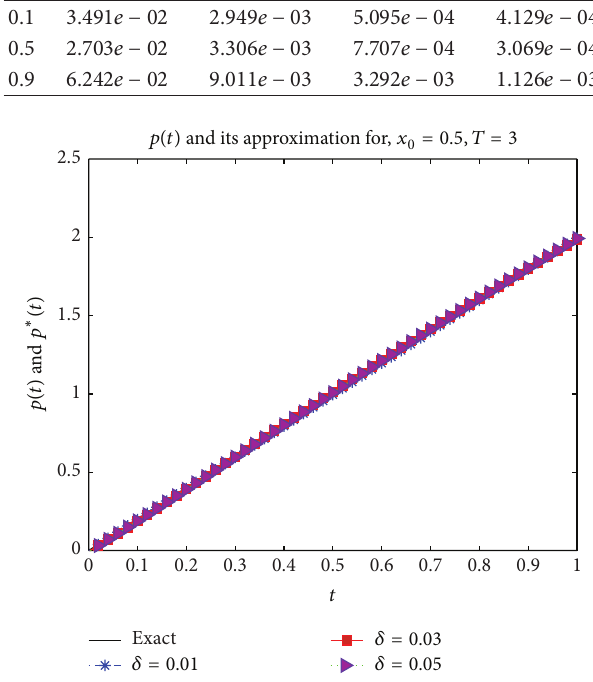
Figure 1: The exact 𝑝 and its approximation 𝑝 ∗ obtained with 𝑁 = = 0.5 and for various levels of noise 20 , 𝑇 = 3 , 𝛿 = 0.01 , and 𝑥 0 added into the data using MQ-RBF with 𝑐 = 0.1 .